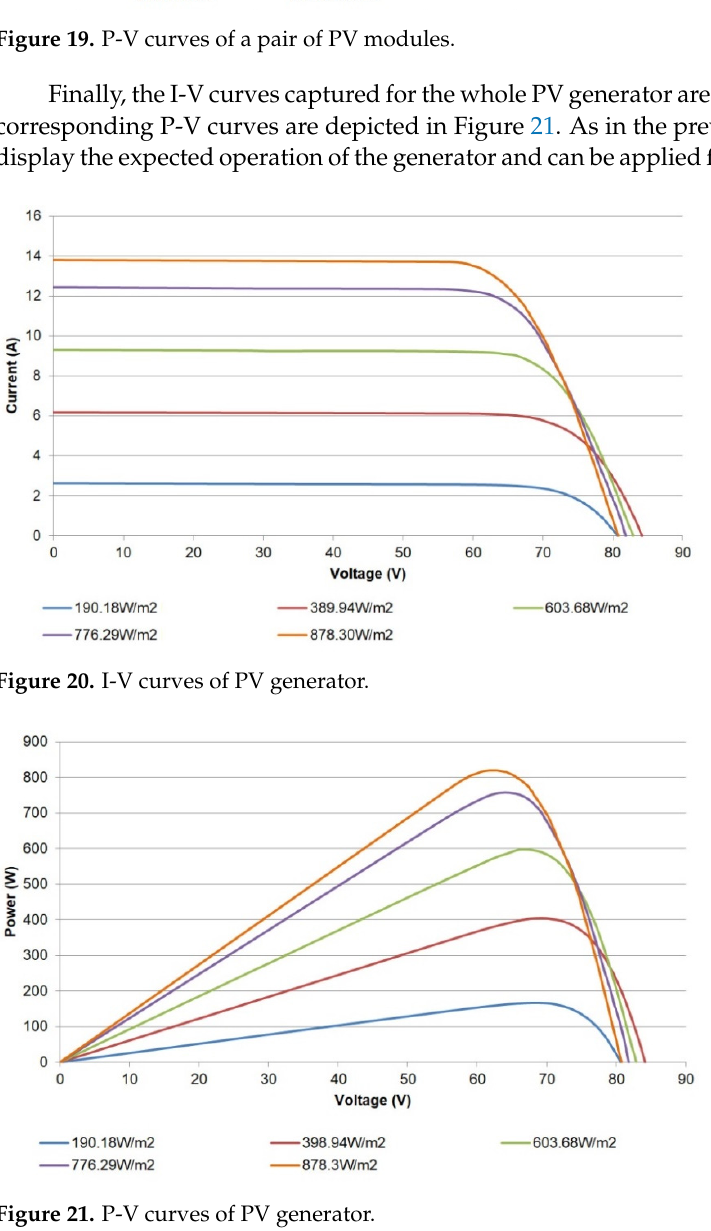
Figure 19. P ‐ V curves of a pair of PV modules.